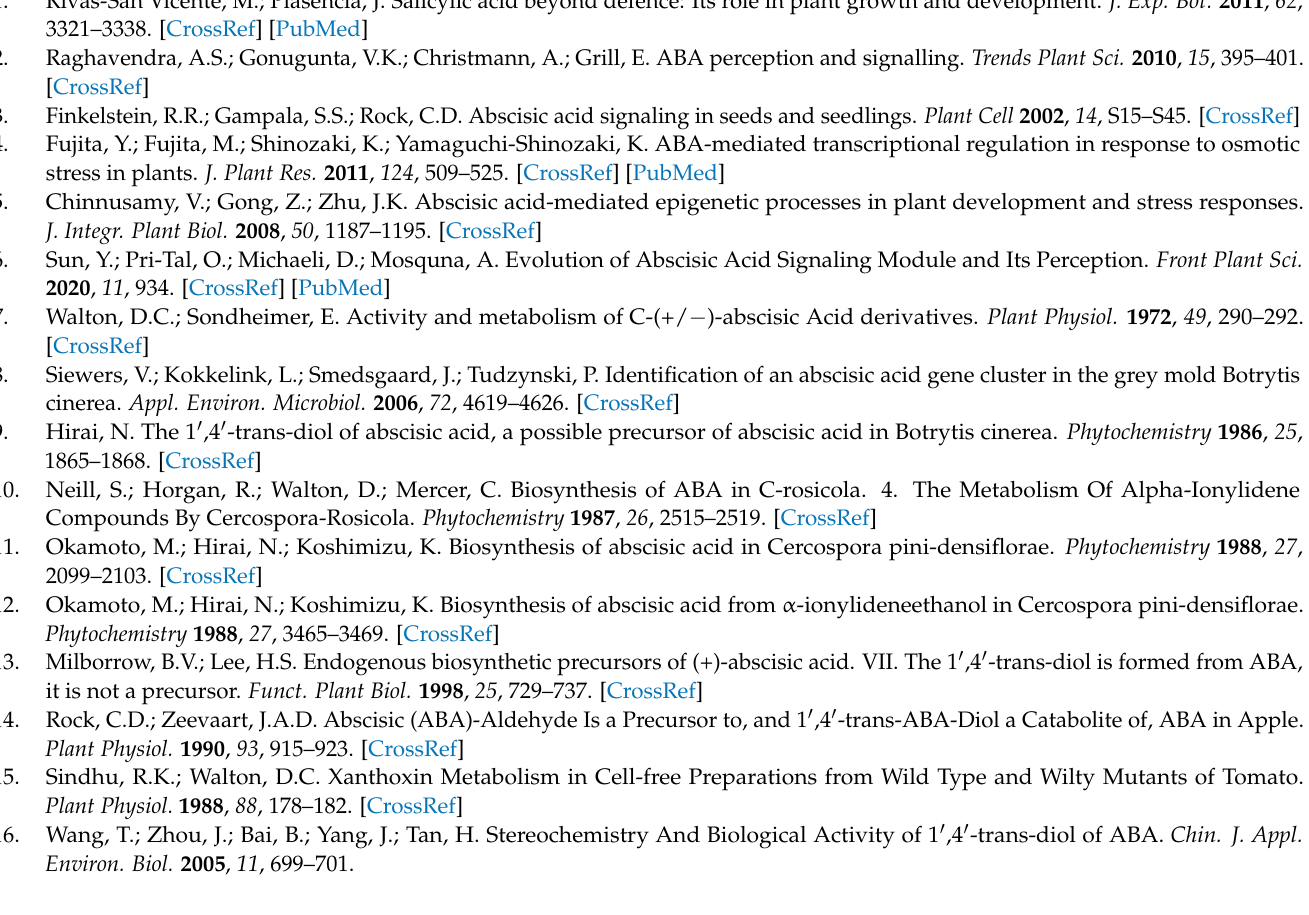
Table S3: Significant GO-term enrichment of 12 h DEGs; Table S4: Significant GO-term enrichment of 24 h DEGs; Table S5: Significant GO-term enrichment of 48 h DEGs; Table S6: Significant KEGG pathway analysis of 12 h DEGs; Table S7: Significant KEGG pathway analysis of 24 h DEGs; Table S8: Significant KEGG pathway analysis of 48 h DEGs; Table S9: Transcription factor family detail; Table S10: Primers for qPCR. Supplementary File S1: The results about HR-ESR-MS and NMR of 1 (cid:48) ,4 (cid:48) - trans